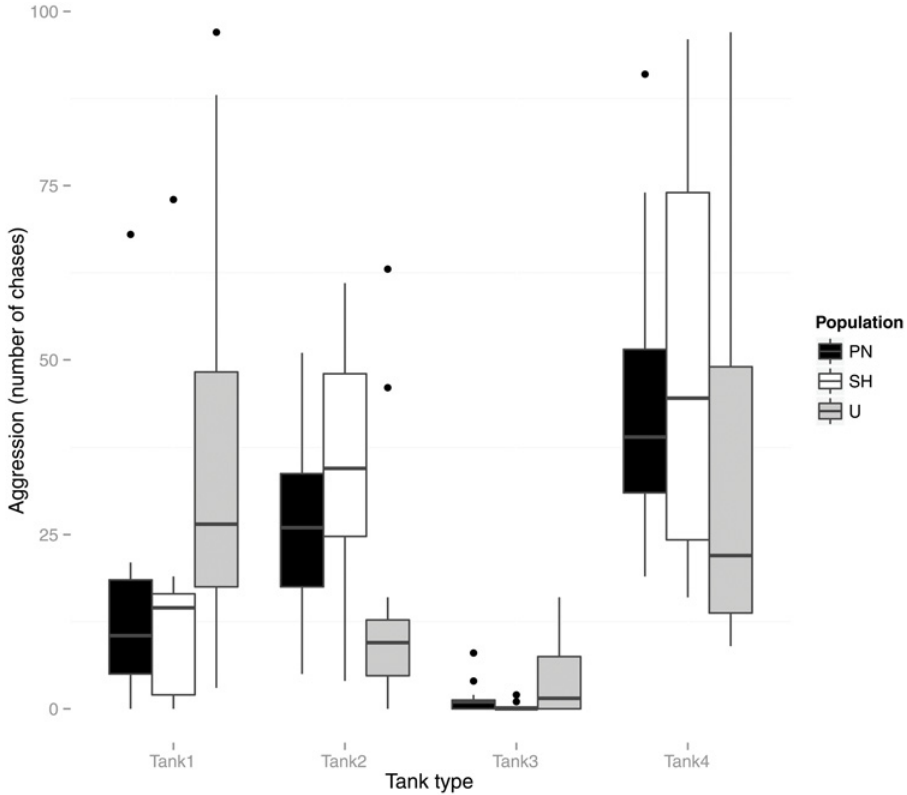
Fig 2. Box-plot representing population-wise measurements of Aggression (total number of chases initiated by individuals in a trial) in each tank treatment type (tank 1, tank 2, tank 3, and tank 4). Tank 1 (Flow, no vegetation), 2 (No Flow, vegetation), 3 (No flow, no vegetation) and 4 (Flow, Vegetation). Outliers are shown as solid